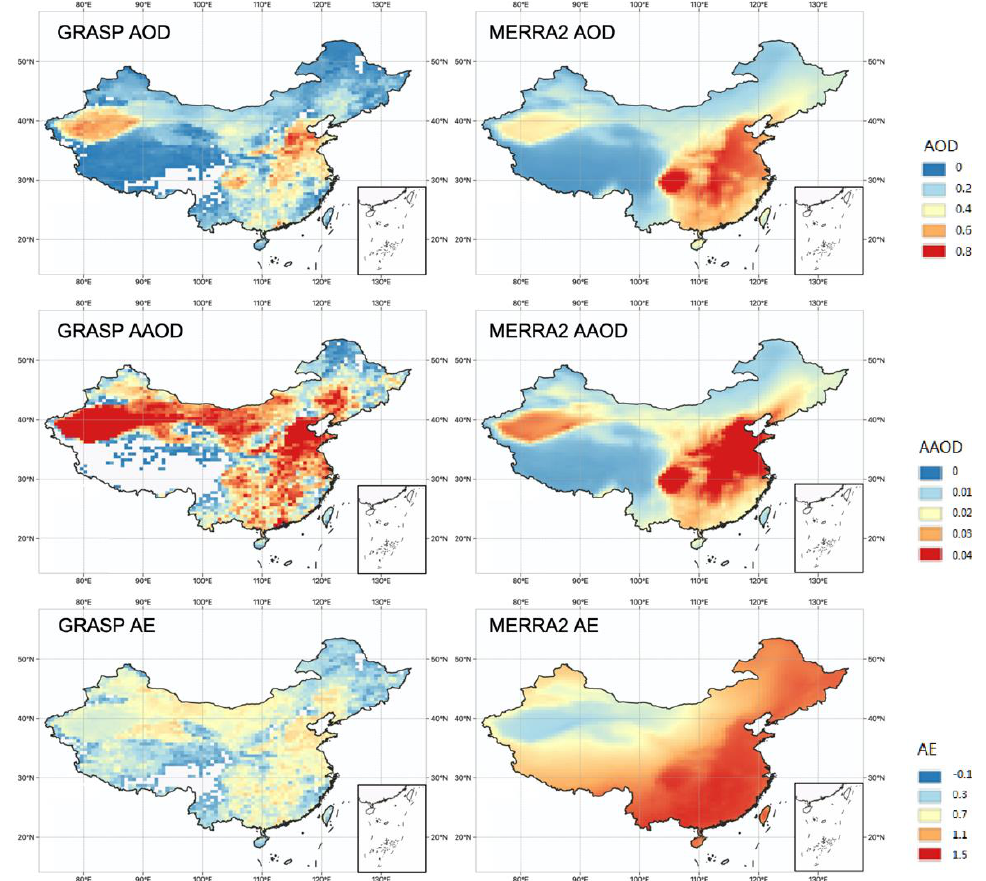
Figure 14. Spatial distribution of 2011–2013 climatological aerosol optical properties from PARA- SOL/GRASP and MERRA-2. The PARASOL/GRASP data is resampled to MERRA-2 0.625 × 0.5° resolution.